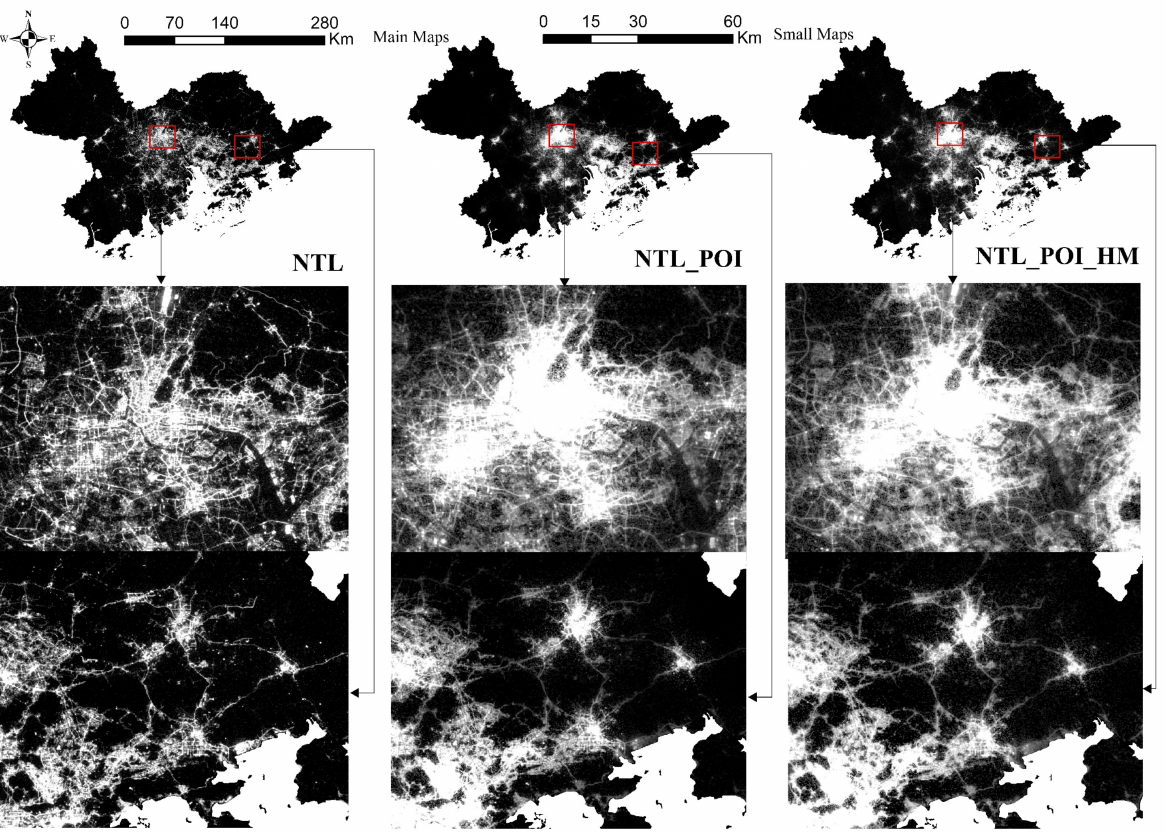
Figure 14. Comparison before and after different data